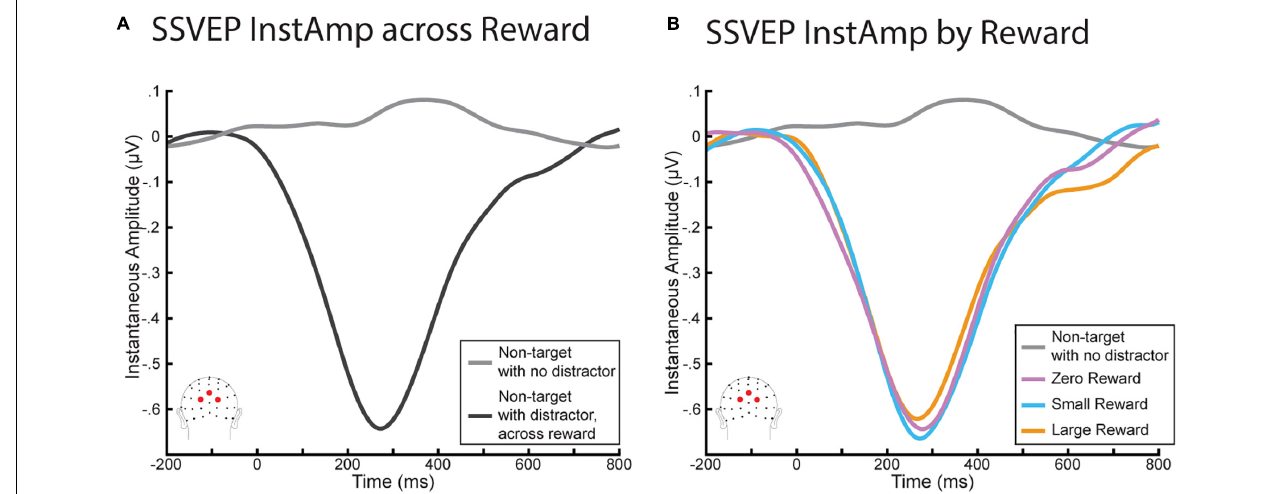
FIGURE 4 | InstAmp results from the RSVP task. (A) Comparing InstAmp when non-targets were presented with and without a distractor of any reward magnitude. Distractors elicited a significant decrease in InstAmp from 0 to 600 ms. (B) InstAmp for distractors by reward. While all distractors generated a significant decrease in InstAmp over this period, this decrease did not differ significantly as a function of reward